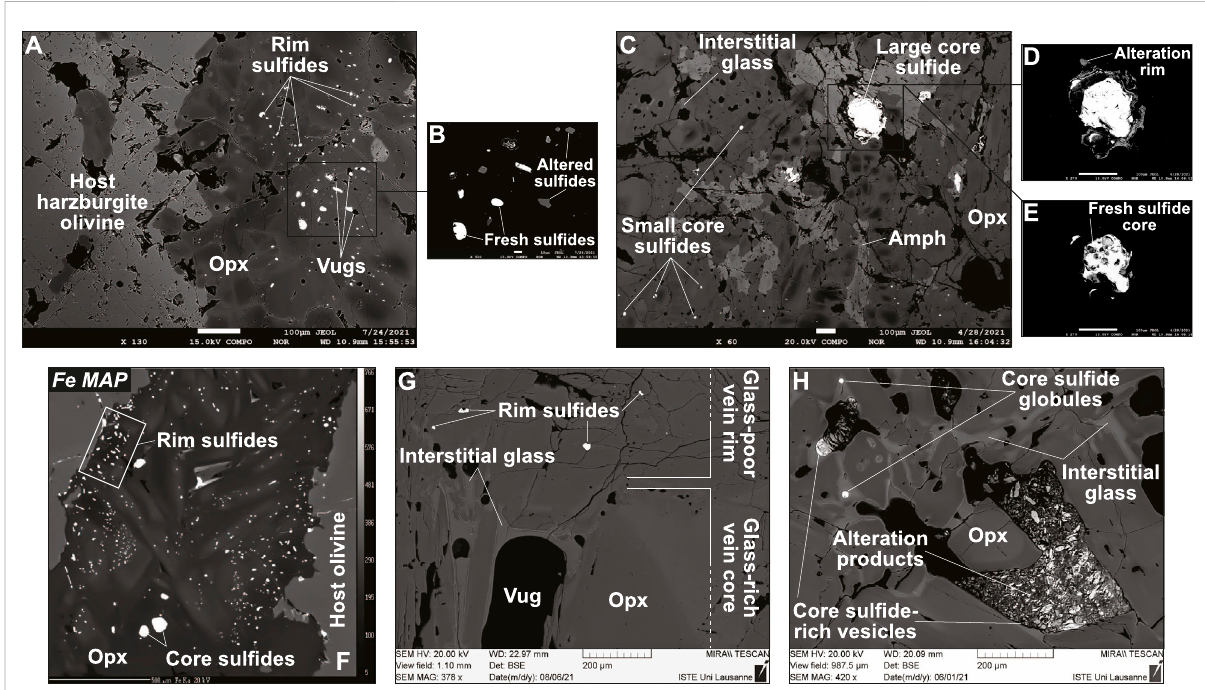
FIGURE 2 Localization and textural features of sul fi des in Kamchatka and West Bismarck Type 1A veins. Data acquired using (A – F) EPMA and (G,H) SEM. BSE images of (A,B) vein rim sul fi des and (C – E) vein core sul fi des in the glass-bearing sample from Kamchatka (sample Av55; Bénard et al., 2022). (F) Fe map of the glass-free vein from Kamchatka (sample Av20; Bénard and Ionov, 2012; Bénard and Ionov, 2013; Bénard et al., 2017b). BSE images of (G) rimsul fi des and (H) coresul fi des intheglass-bearingveinfromWest Bismarck(sample67-02E(3);Bénardetal.,2018c).Scalebaris100 μ m in (A) and (C – E) , 10 μ m in (B) and 500 μ m in (F) . Note the generally smaller sizes of rim sul fi des, which are also more abundant than core sul fi des, presumably because of the higher melt-rock reaction rates with S 6+ -Fe 2+ redox exchange in the former areas (see text for details). Sul fi de-rich vesicles are only present in the glassy core of the West Bismarck vein. Amph,